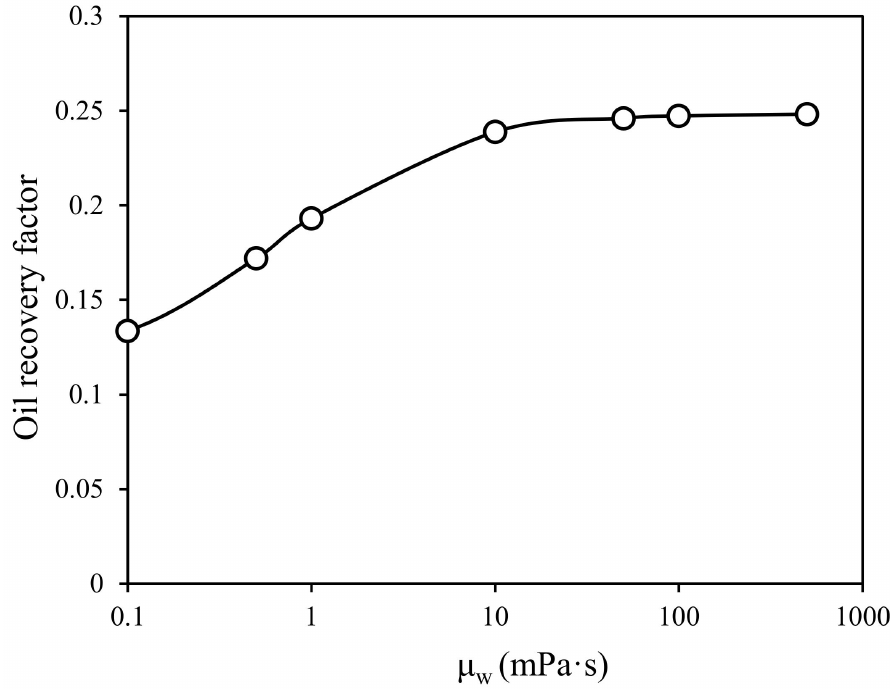
Figure 10. Oil recovery factor of different wetting phase viscosities of three interacting capillaries.